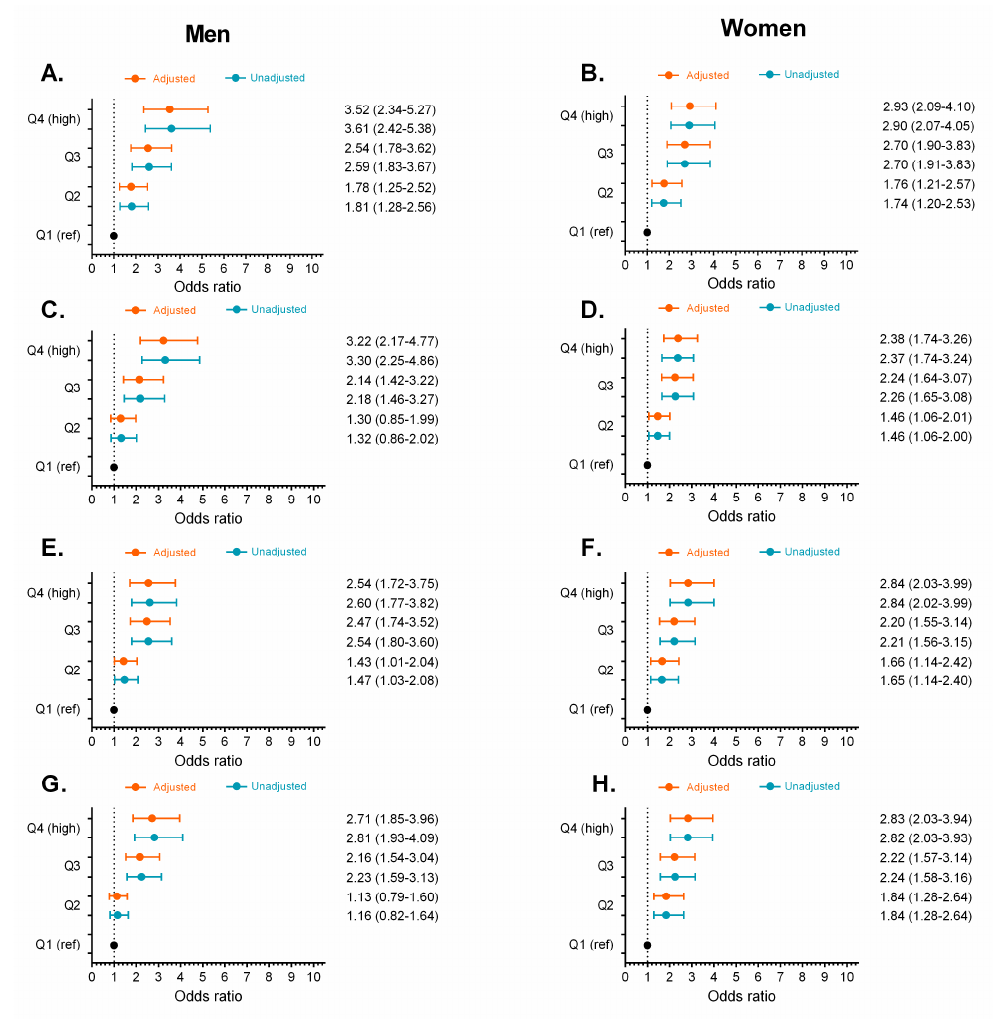
Figure 6. Unadjusted odds ratios () and adjusted odds ratios () for prediabetes in quartiles (Q) of obesity- and lipid-related indices by sex. ABSI Panel ( A,B ), C ( C,D ), VAI ( E,F ), and TyG ( G,H ) by sex. Odds ratio adjusted for age, smoking, drinking, and physical activity “proxy”. (Q1 reference “lowest” group), second quartile (Q2), third quartile (Q3), and fourth quartile (Q4 highest group).